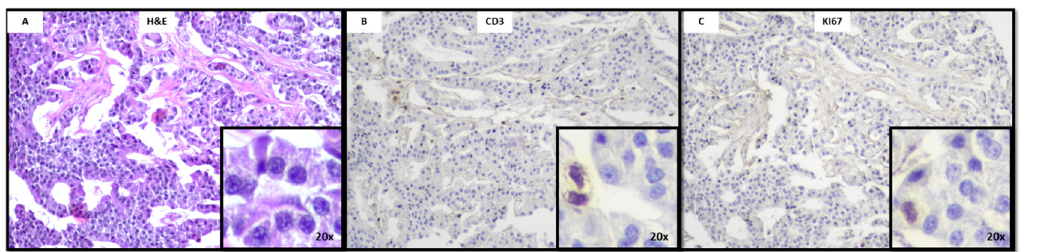
Figure 1. Microscopic images of GC-1 cases. Histological sections of a well-differentiated Type 1 gastric neuroendocrine tumor ( A ) ECL cell tumor-hyperplasia is associated with atrophic gastritis, showing more solid aggregates of cells with moderately hyperchromatic nuclei H&E stain ( × 10, × 20). ( B ) T-lymphocyte infiltrate using CD3 staining ( × 10, × 20). ( C ) Ki-67 nuclear proliferative index <2% (Phosphohistone H3 Immunohistochemical stain) ( × 10, × 20).